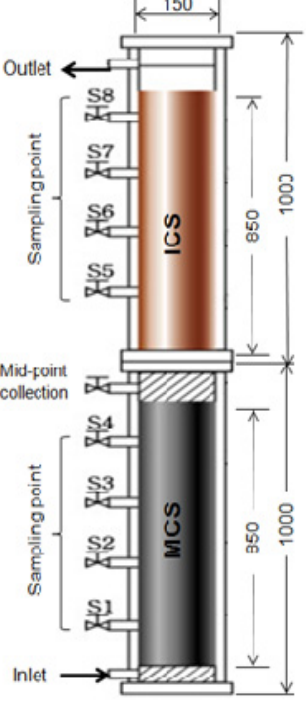
Figure 4. Schematic apparatus of reactive sand filtration tower (RSFT) (scale unit: mm) (initial As(III) = 1.0 mg/L, Q = 22.5 mL/min) (after